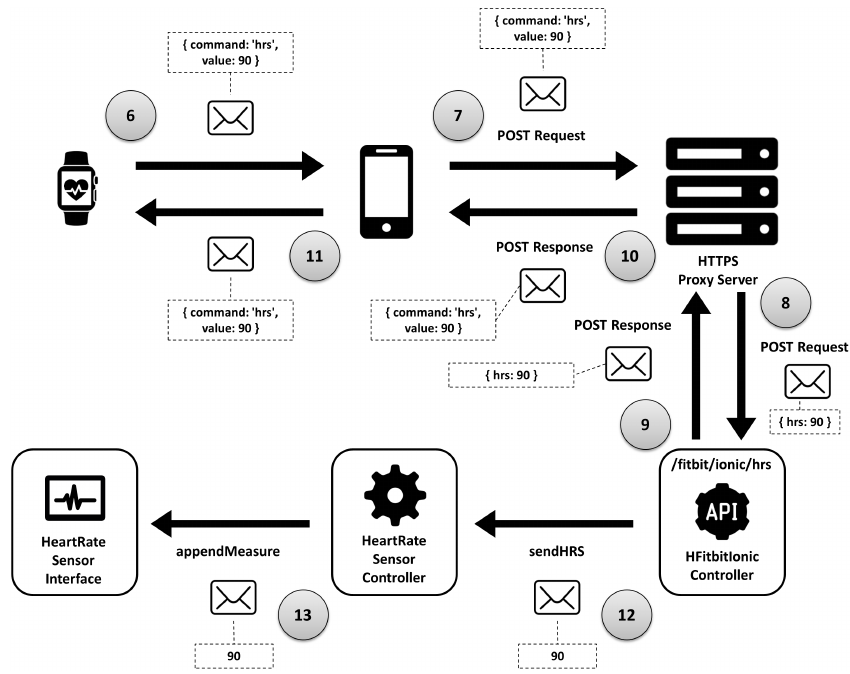
Figure 9. Communications of interaction human-to-human (second